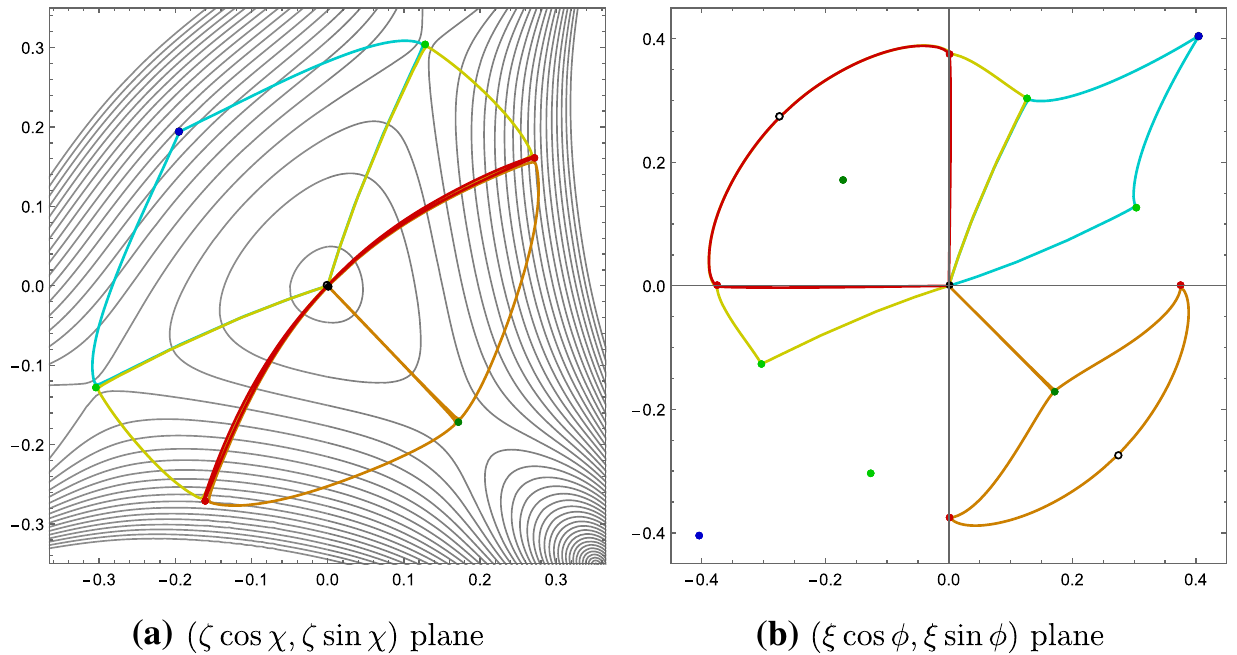
Fig. 13 SO ( 8 )/ SO ( 8 ) Janus solutions that flow to U ( 3 ) , G 2 , G 2 and SU ( 3 ) critical points with ω = π superpotential by red, green, dark green and blue lines, respectively